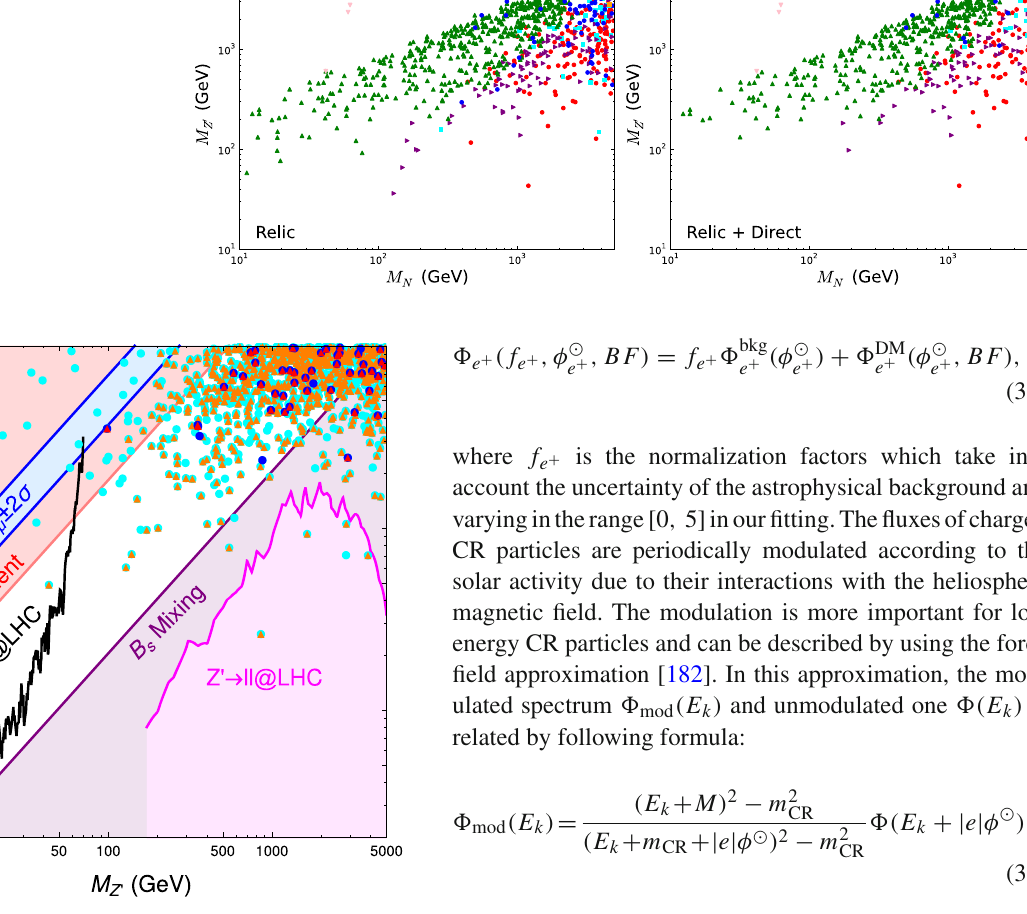
Fig. 3 Survived samples in the g (cid:3) - M (cid:3) plane with constraints from Z Sect. 3.1. The constraint t → cZ (cid:3) excludes g (cid:3) (cid:2) 4 × 10 − 4 , which is too small to show here. The cyan circle points satisfy relic density only, while the orange triangle points further satisfy direct detection. Blue circle points satisfy relic density and neutrino oscillation, and the red triangle points further satisfy direct